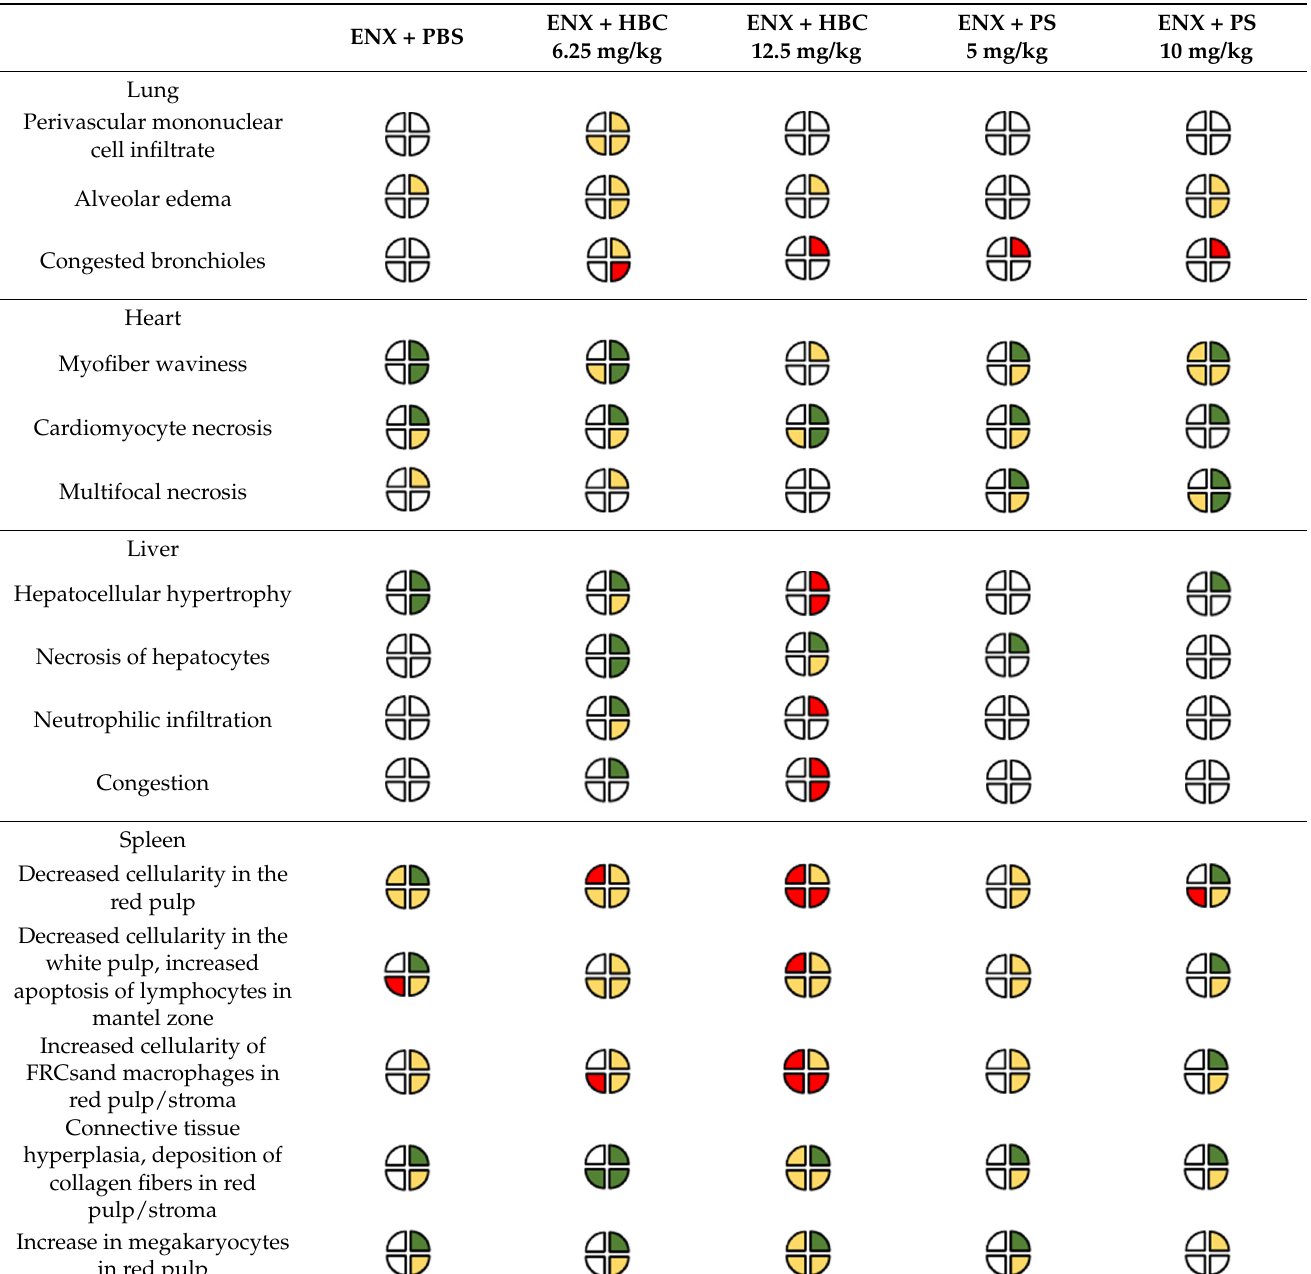
Decreased cellularity in the white pulp, increased